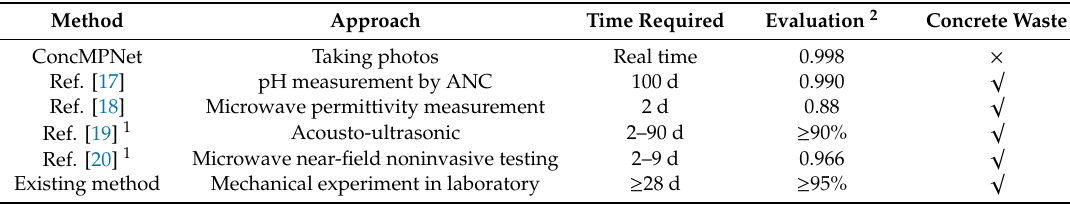
Table 17. Comparative study of ConcMPNet, method proposed by references and existing testing method.